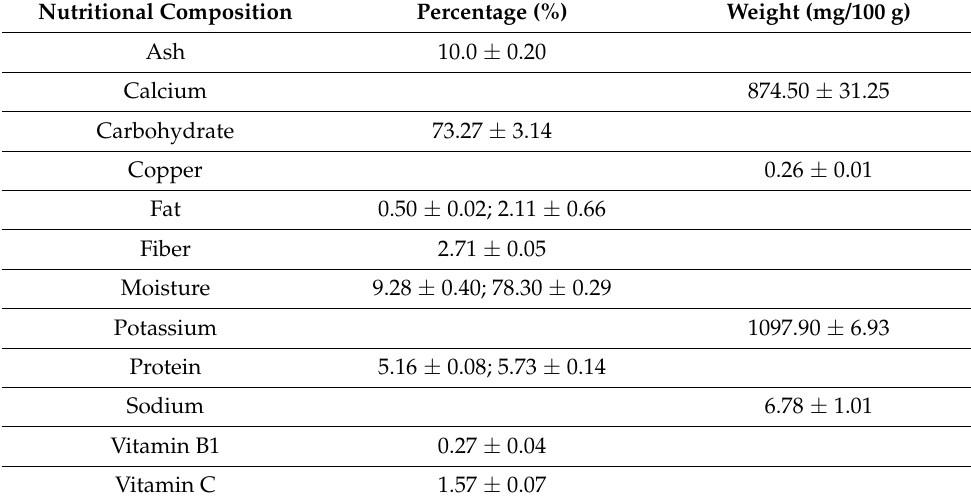
Table 5. Nutritional composition of C. nutans